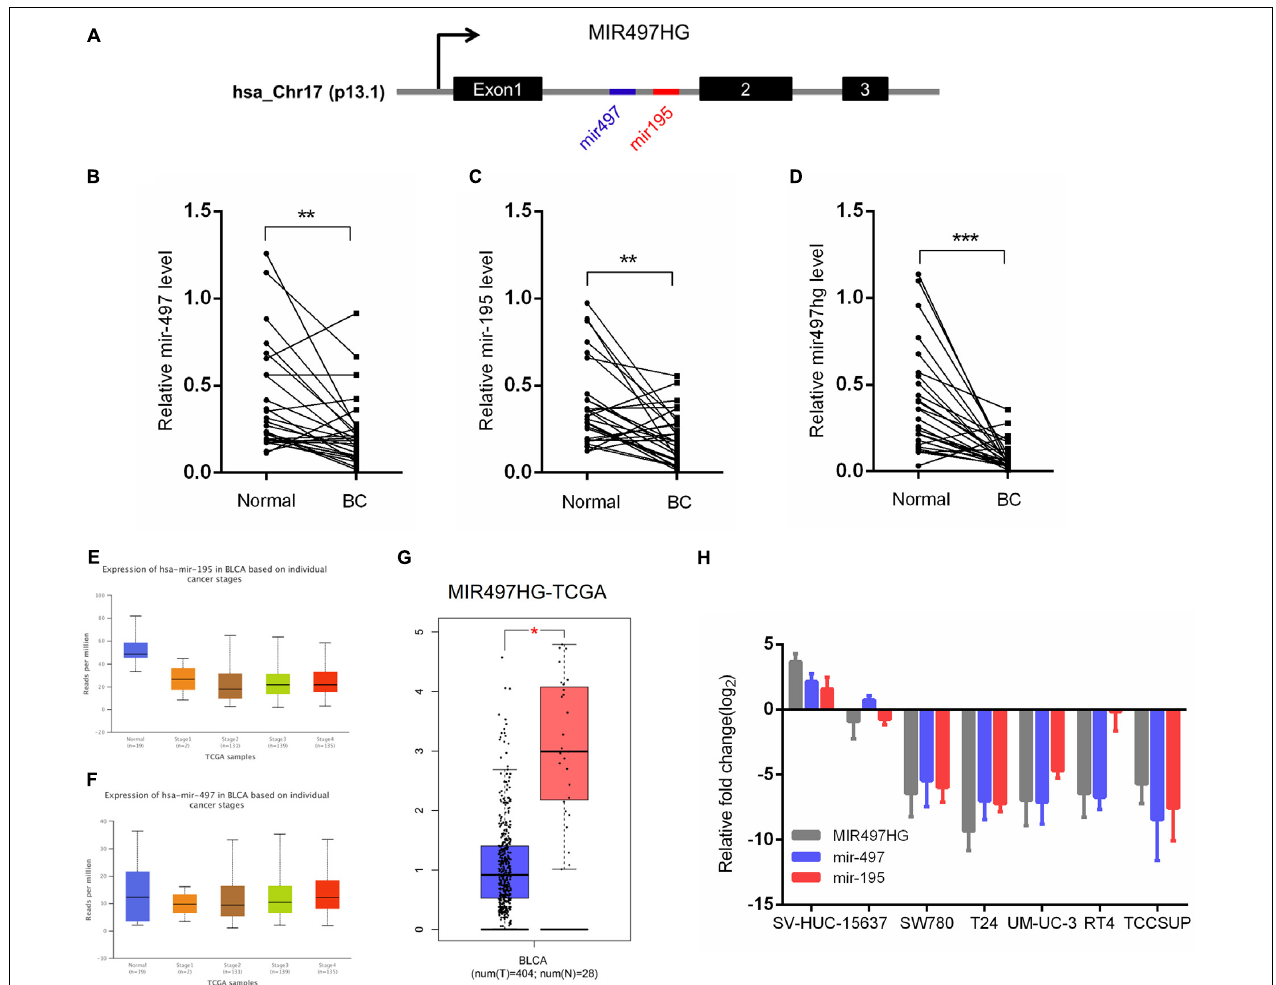
FIGURE 1 | MIR497HG and embedded miR-497 and miR-195 were downregulated in bladder cancer. (A) Genomic representation of MIR497HG, host gene of the miR-497/195 cluster, was shown on human chromosome 17. (B–D) The expression of MIR497HG and miR-497/195 cluster analyzed by qRT-PCR in 27 paired BCa tissues and adjacent normal tissues. ** P < 0.01 and *** P < 0.001 by paired-samples t test. (E–G) TGCA bladder cancer datasets were analyzed for MIR497HG and miR-497/195 cluster expression. * P < 0.05. (H) The qRT-PCR analysis of MIR497HG, miR-497, and miR-195 expression levels among a panel of 7 BCa cell lines. GAPDH or U6 snRNA served as the internal